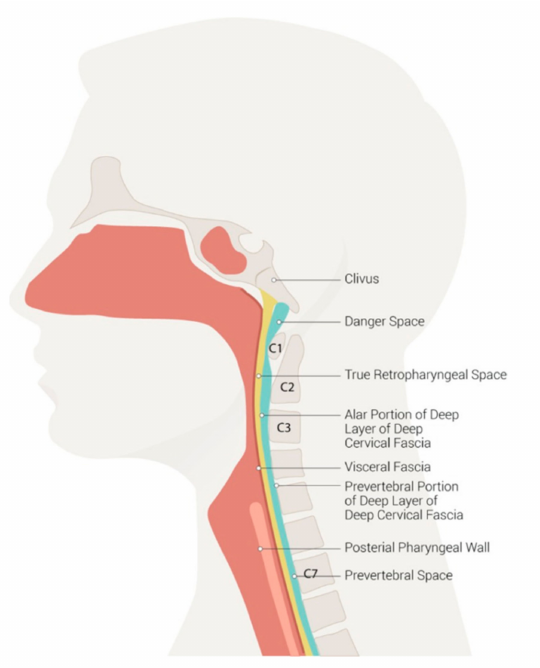
Figure 2. Neck spaces. Licensed under CC by 4.0. Available from: https://www.ncbi.nlm.nih.gov/ books/NBK537044/figure/article-36304.image.f1/ (Accessed on 18 March